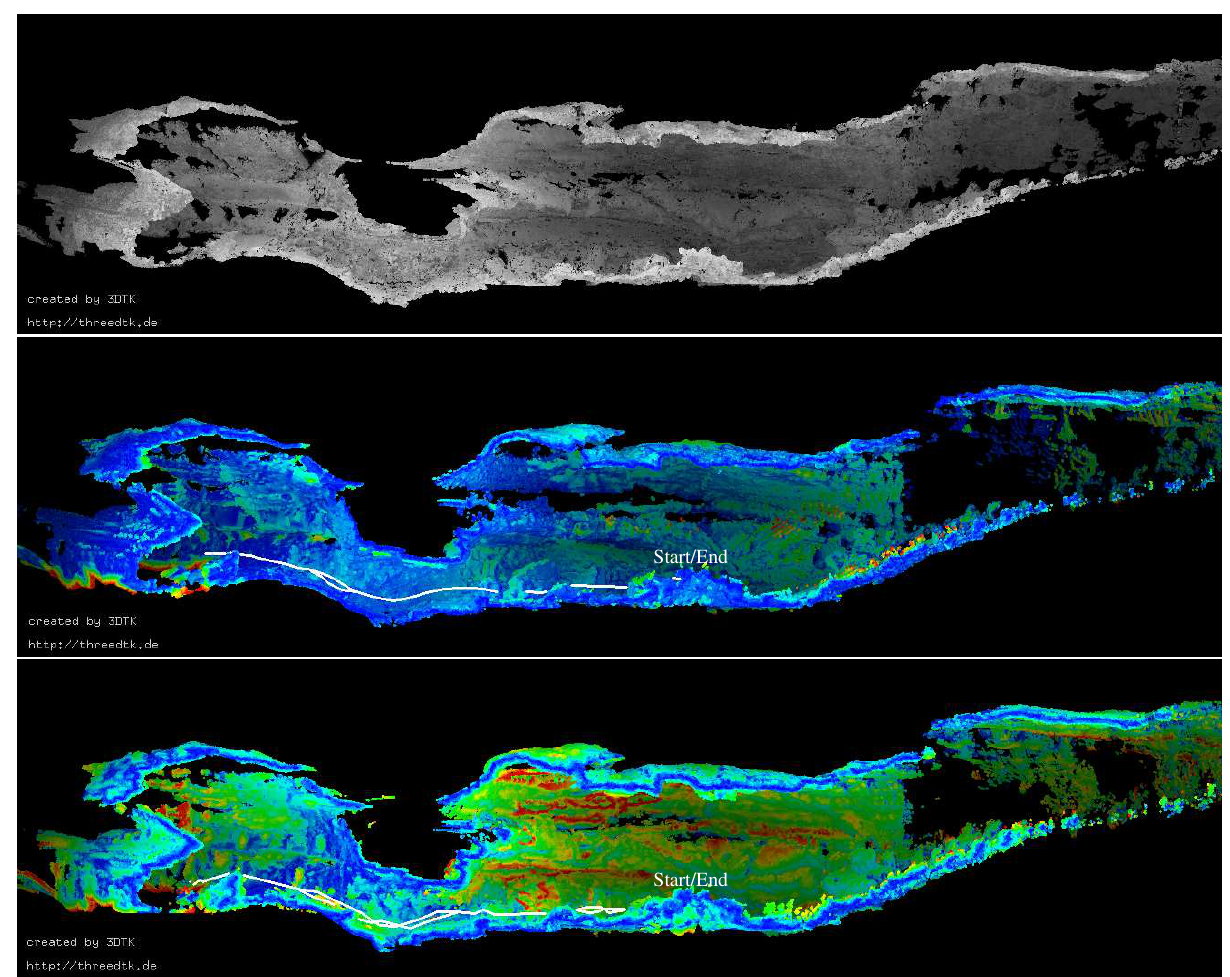
Figure 9. Side view of the point clouds. The front plane is cropped for better visibility. Above: Ground truth. Middle: Dataset Trajectory3D. Below: Dataset Trajectory2D. Ground truth is colored by reflectance values. Dataset Trajectory3D and dataset Trajectory2D are colored by deviation from ground truth. Blue indicates low and red large errors.